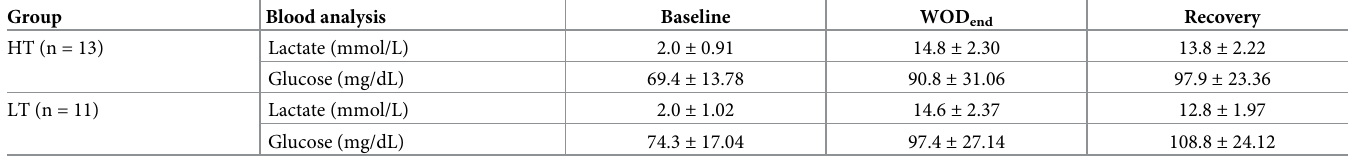
Table 2. Capillary blood lactate and capillary blood glucose in the two groups of CF participants at rest (Baseline), at the end of the “Fran” workout (WOD end ) and after a 15-min recovery (Recovery). Data are means ± SD. One-way